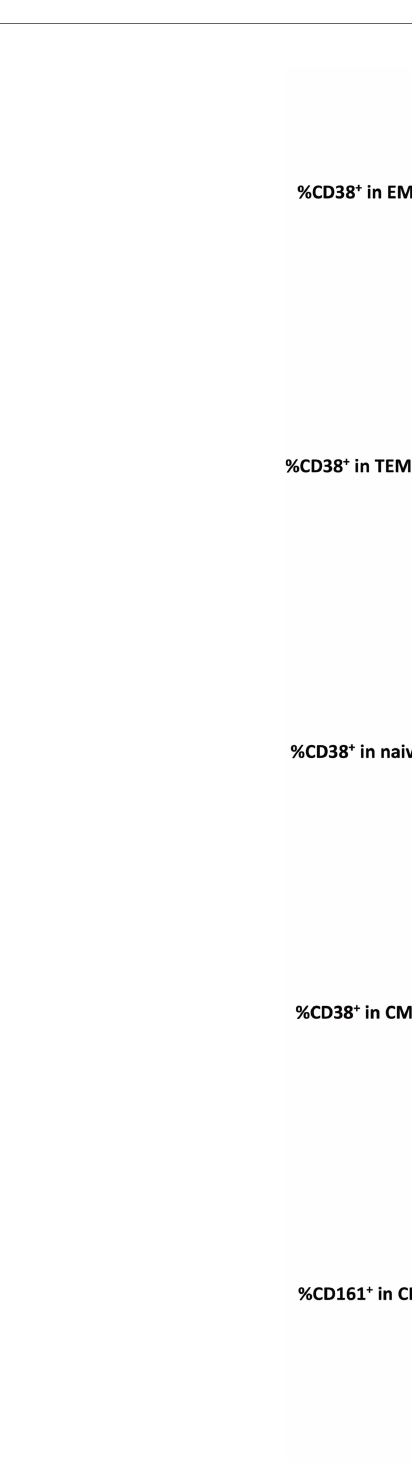
FIGURE 4 | CD38 + CD8 + activated T cell populations and CD161 + CD8 + T cells in peripheral blood. Frequencies of CD38 + positive cells in (A, B) CD8 + effector memory, (C, D) CD8 + TEMRA, (E, F) CD8 + naïve, (G, H) CD8 + central memory T cells as well as frequencies of (I, J) CD161 + CD8 + T cells were measured in the peripheral blood of (A, C, E, G, I) HD- and (B, D, F, H, J) non-HD patients without SARS-CoV-2 infection (orange circles, HD: n = 10; light blue circles, non-HD: 6), with mild/asymptomatic (light red circles, HD: n = 18; mid blue circles, non-HD: n = 9), moderate (red circles, HD: n = 11; blue circles, non-HD: n = 11) and severe COVID-19 disease (black circles, HD: n = 2; dark blue circles, non-HD: n = 13). Severe and moderate COVID-19 HD patients were analyzed as one group. Data are shown as individual values as well as